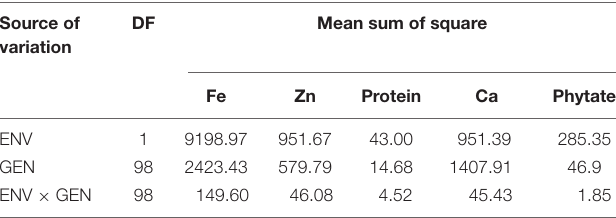
TABLE 3 | Combined Analysis of variance for grain nutrients and antinutritional factors over two locations in V. stipulacea accessions. Source of DF Mean sum of variation